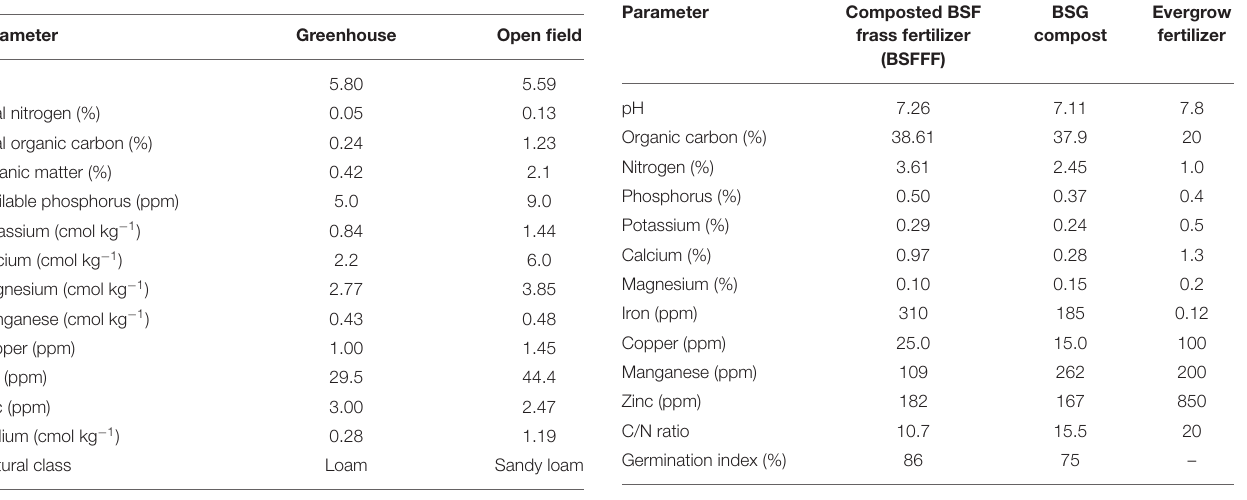
TABLE 1 | Selected characteristics of soils used during green house and open-field experiments.